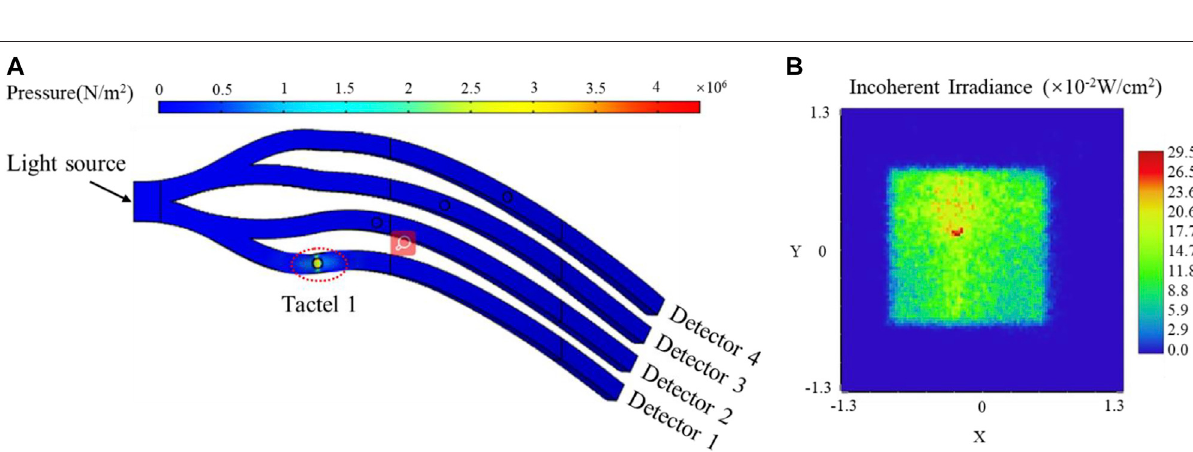
Frontiers in Robotics and AI |